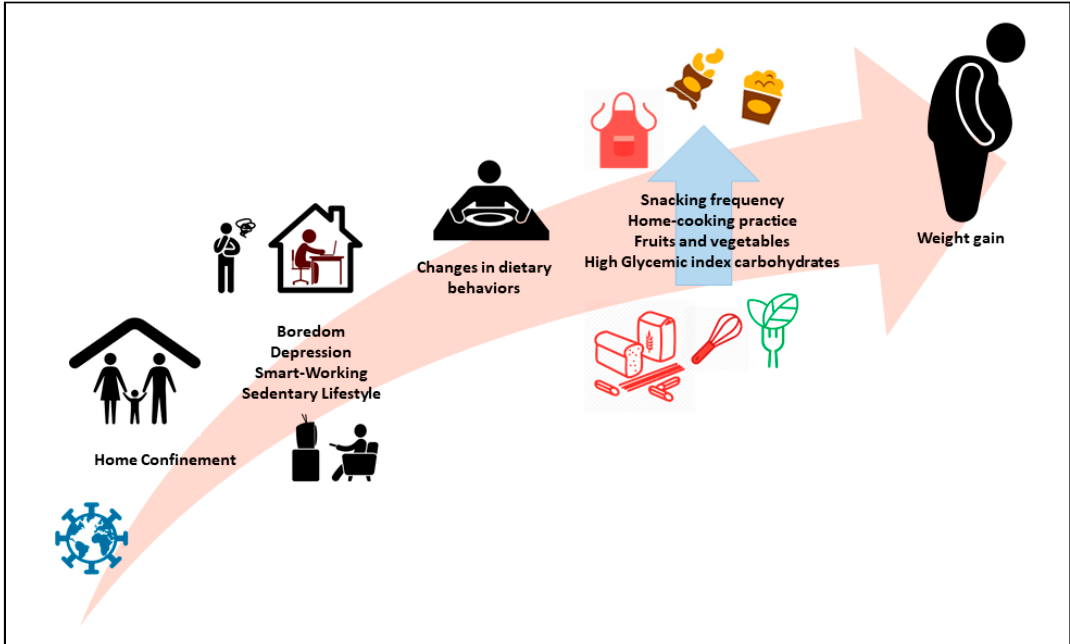
Figure 2. Food trajectories triggered by the COVID-19 home confinement.